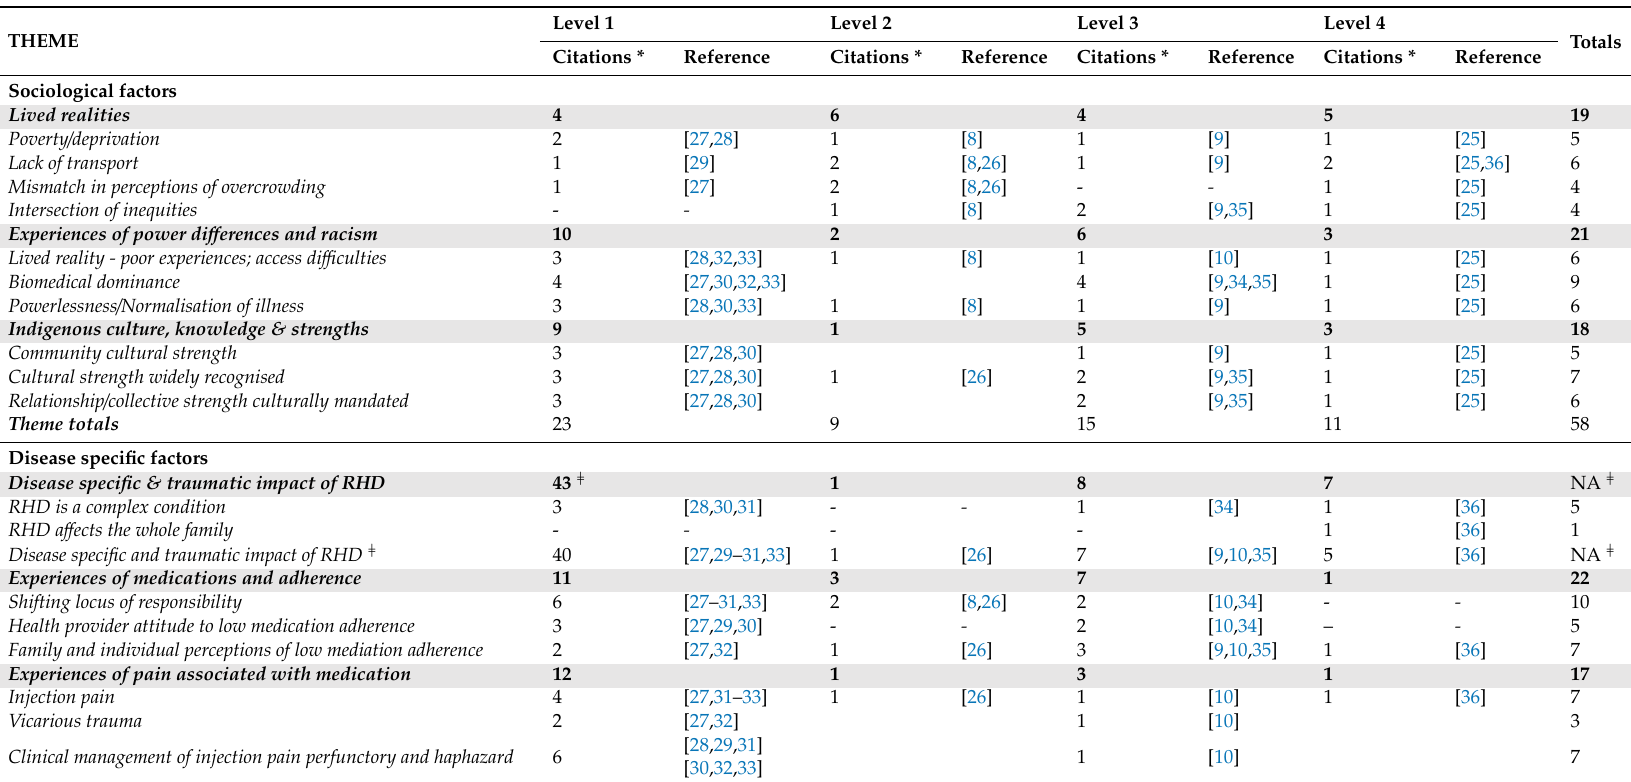
Table A2. Themes and sub-themes analysed according to frequency and hierarchy of evidence for practice (Daly et al.)